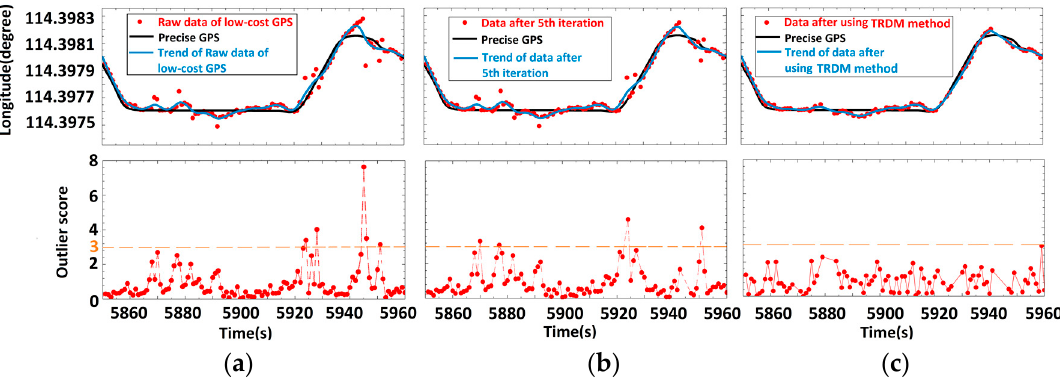
Figure 4. Iterations of the TRDM method in longitude for the problematic segment of Figure 3d. ( a ) Raw data; ( b ) the fifth iteration; ( c ) cleaned data.